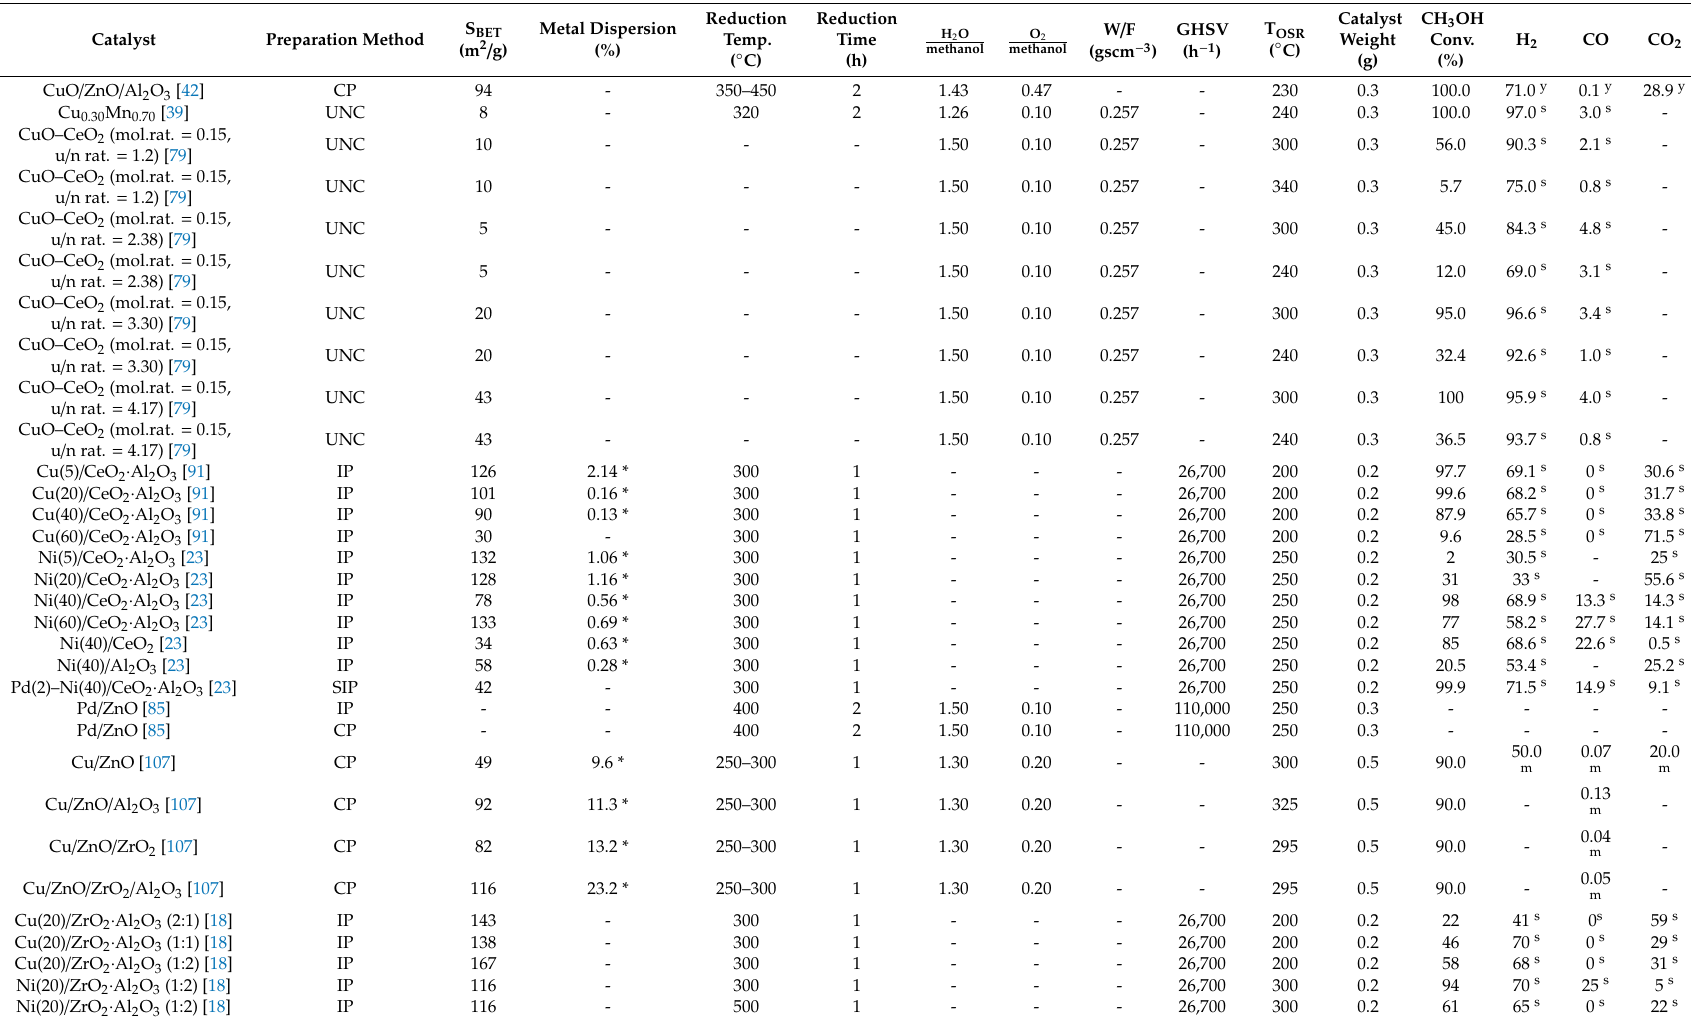
Table 4. The physicochemical and catalytic characterization of the various catalysts applied in OSR of methanol reaction.